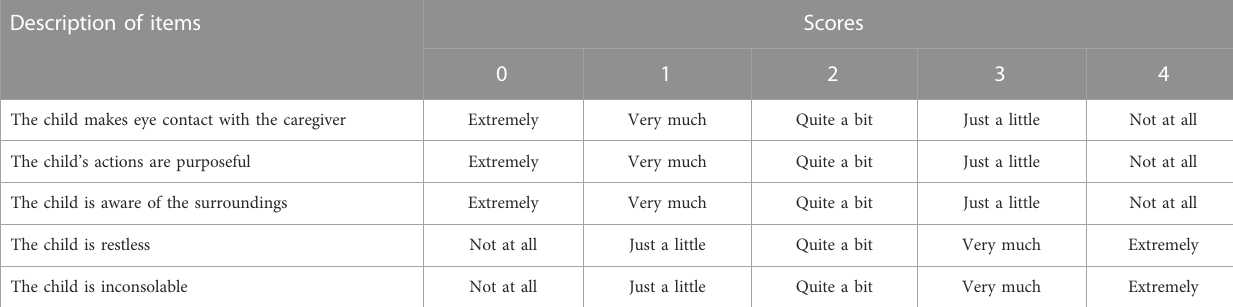
TABLE 1 Pediatric Anesthesia Emergence Delirium